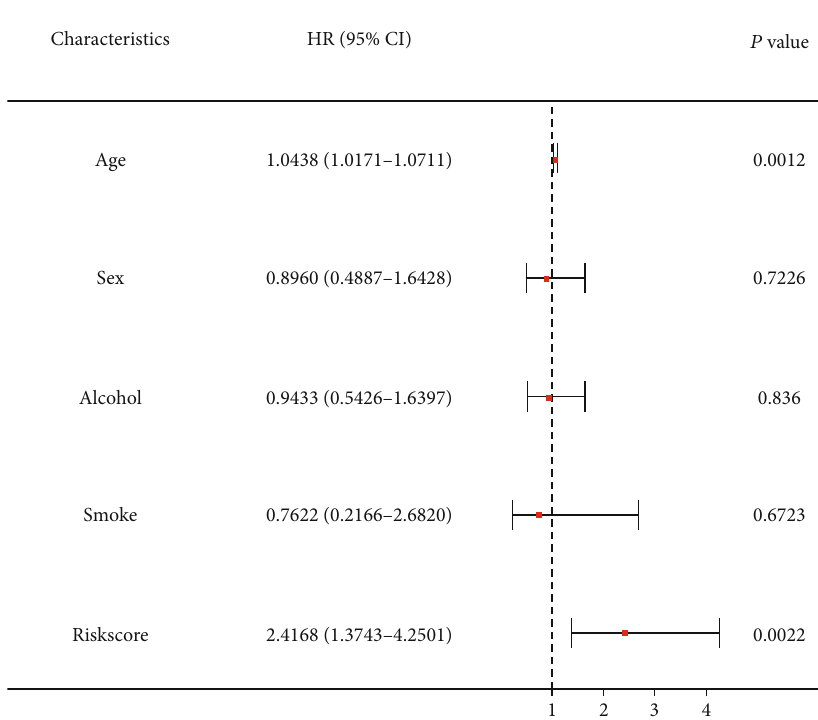
Figure 3: Forest plot for multivariate Cox regression